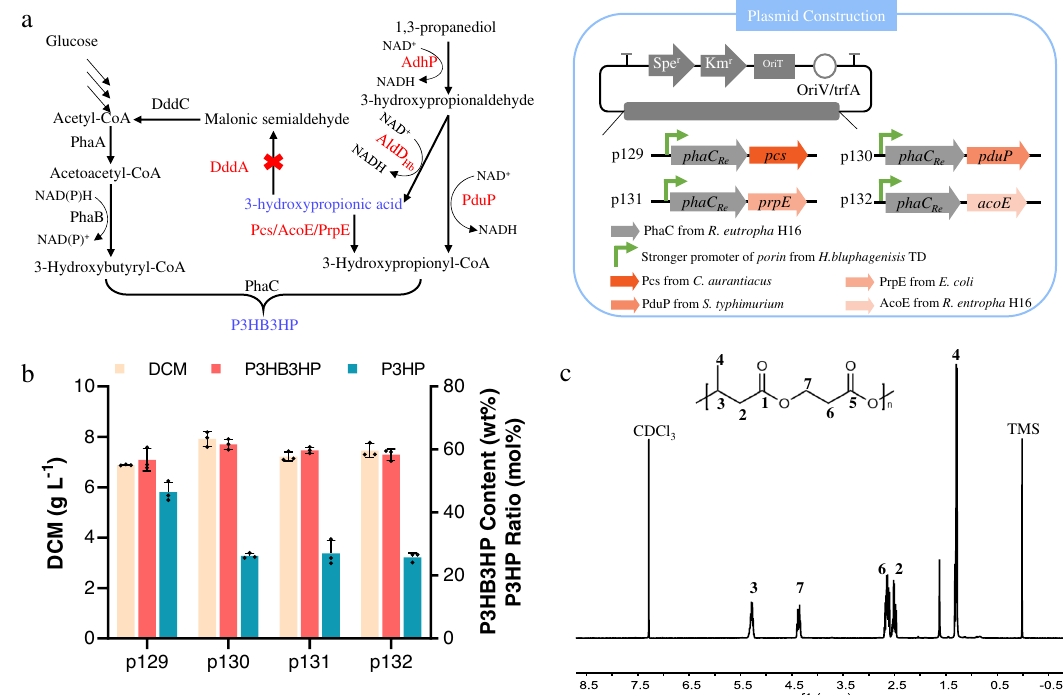
Fig. 5 Enzyme screening for improving biosynthesis of P3HB3HP by engineered H. bluephagenesis TD27. a Strategies for microbial co-production of 3HP and P3HB3HP involving a combination of genome-based gene expression and plasmid-based gene expression. Red color “ X ” indicates the inactivation of metabolic pathways. Gene adhP encodes 1,3-propanediol dehydrogenase from H. bluphagenesis , aldD Hb encodes aldehyde dehydrogenase from H. bluphagenesis , pcs encodes coenzyme A ligase domain from Chloro fl exus aurantiacus , pduP encodes propionaldehyde dehydrogenase from Salmonella typhimurium , prpE encodes propionyl-CoA synthase from E. coli , acoE encodes acetyl-CoA synthase from Ralstonia entropha . Genes were expressed under the control of constitutive promoters in a multiple-copy episomal plasmid pKS. b P3HB3HP contents and monomer compositions generated by engineered H. bluephagenesis TD27 overexpressing different 3-hydroxypropionyl-CoA biosynthetic genes. Cells were grown in the modi fi ed minimal medium containing 20 g L − 1 glucose, 10 g L − 1 1,3-propanediol, and 6 g L − 1 acetic acid. All titers were obtained after 48 h cultivation at 200 r.p.m. and 37 °C. The initial pH of all shake- fl ask studies was 9. All data represent the mean of n = 3 biologically independent samples and error bars show s.d. c 1 H NMR of P (3HB- co -40% 3HP) copolymers produced by the engineered H. bluephagenesis TD27 overexpressing pcs . TMS tetramethylsilane (internal